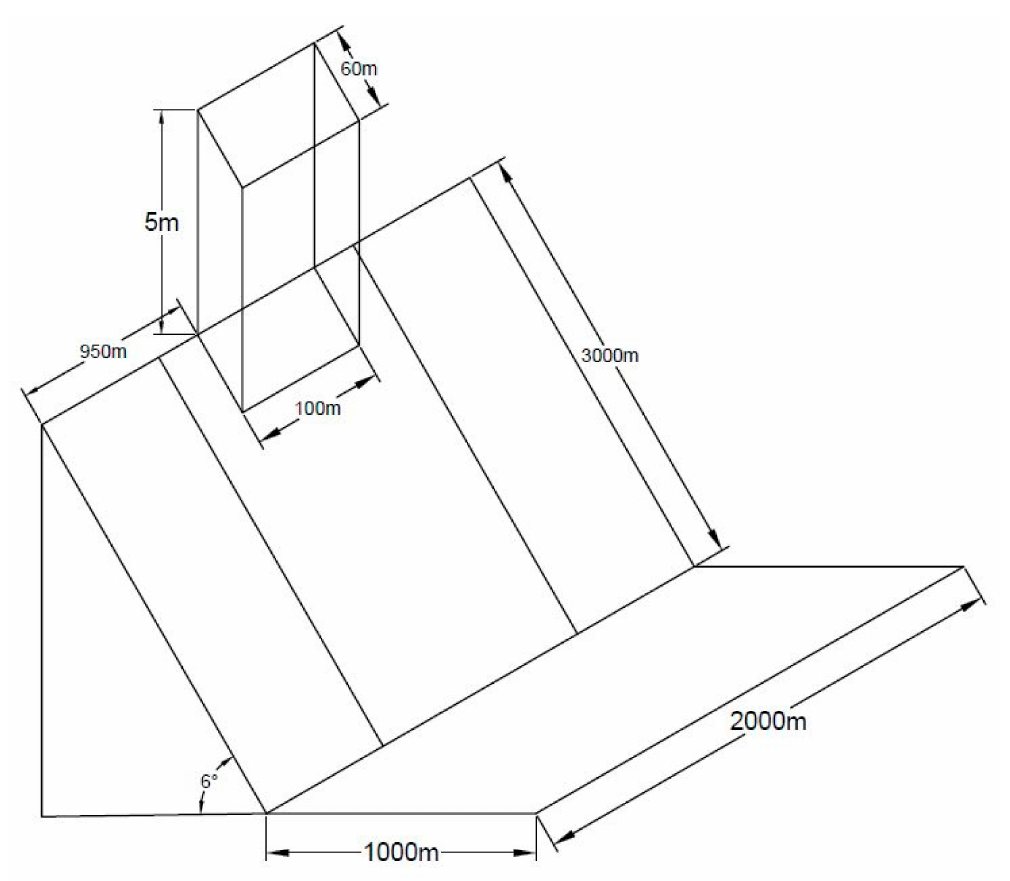
Figure 5. Schematic diagram of a continental shelf that leads to the deep sea (not drawn to